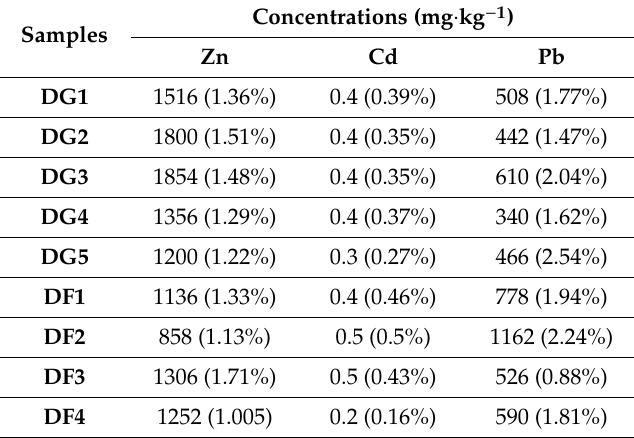
Table 2. Contents of the (bio)available fractions of the potentially toxic elements (PTEs) in coarse mine tailings (DG) and fine grainsize tailings